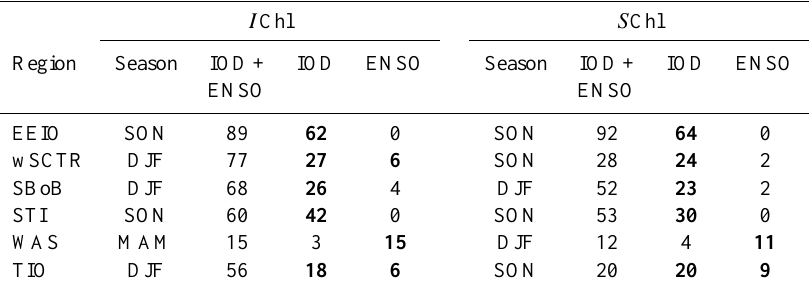
Table 3. Percentage of interannual chlorophyll variance explained by regressions including DMI+Niño3.4 as explanatory variables (first column) and for the partial regression of each climate mode in isolation (2nd and 3rd columns; proportion from Eq. 7 multiplied by 100). The season selected was that in which the multiple regression (first column) explained the greatest proportion of I Chl or S Chl variance. Bold figures indicate when partial regressions resulted in a significant coefficient ( p < 0 .